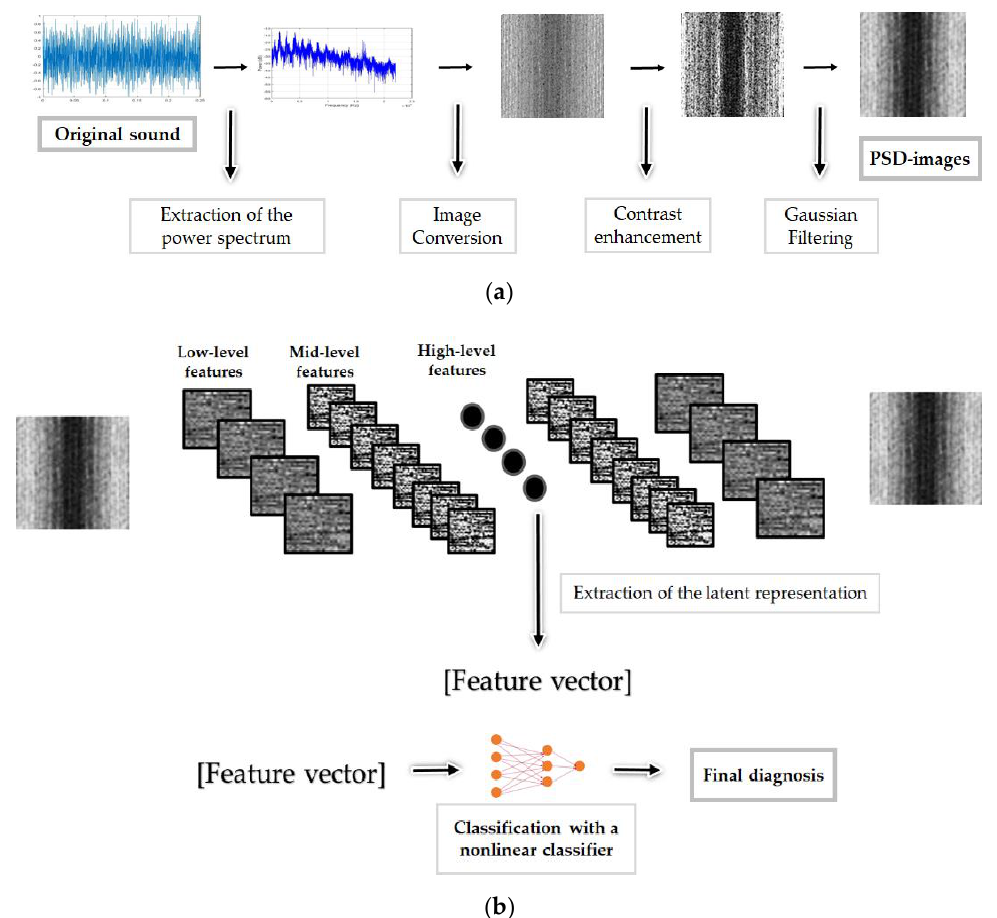
Figure 1. The schematic representation of the proposed fault diagnosis method: in ( a ), we have the building of the power spectral density (PSD)-images, and in ( b ) the deep convolutional autoencoder (DCAE) based feature learning process using the PSD-images, and the final part consisting of the nonlinear classification.